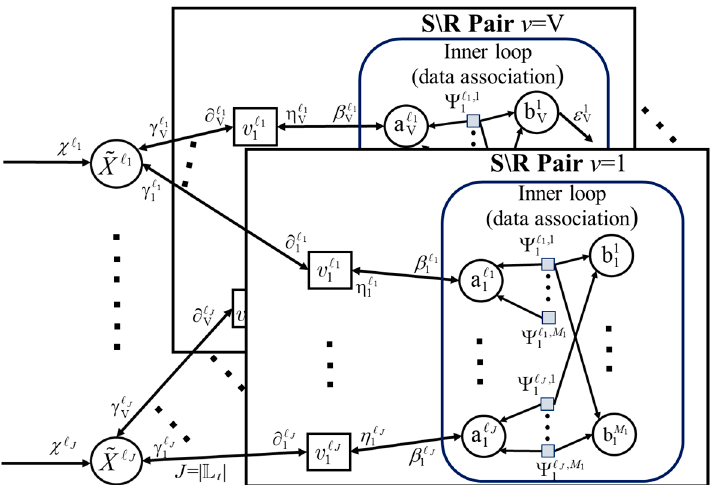
( ) (cid:12) (cid:16) (cid:17) ,, | f Z a b  X in (33). The abbreviations are (cid:12) in (33). The abbreviations are (cid:101) X t , a t , b t 1: t t t t (cid:12) Z 1: t (cid:44) ∂ (cid:96) (cid:96) ( (cid:96) ) ; Z t , v ) , = v t , v ( (cid:101) X (cid:96) ( (cid:101) X (cid:96) ) , v (cid:96) t | t − 1 , ∂ v v v t | t − 1 ,a t , v t | t − 1 (cid:96) (cid:44) (cid:44) a (cid:44) b Ψ (cid:96) , m m ) , a (cid:96) t , v ( (cid:96) ) , b t , v ( m ) , and v v v t | t − 1